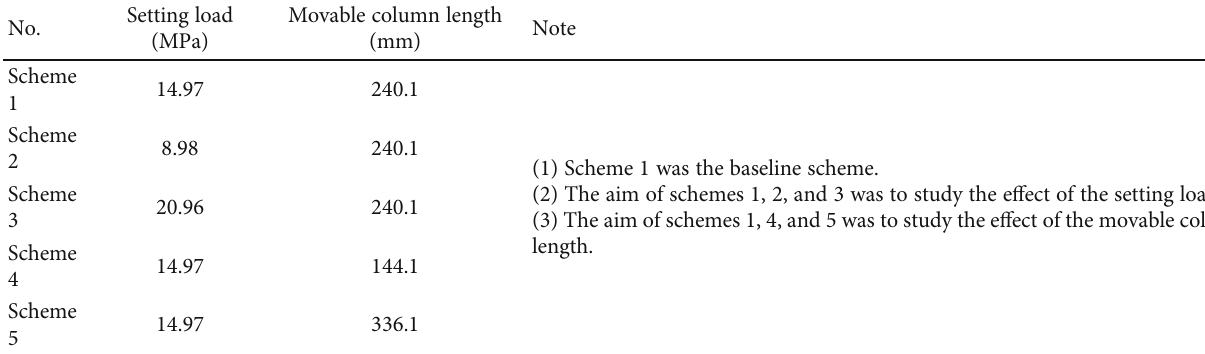
Table 3: Schemes of numerical